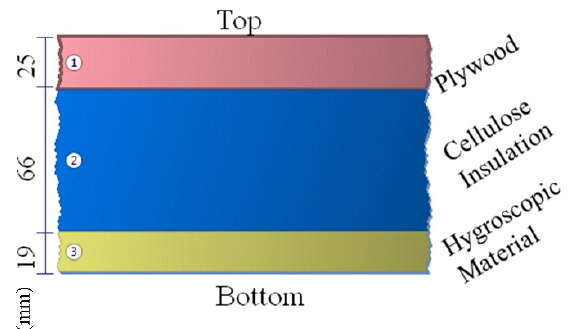
Figure 4. Roof construction.